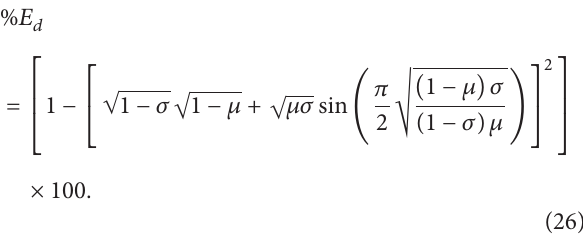
(18) is expressed in terms of the mass ratio 𝜇 and the stiffness ratio reduction 𝜎